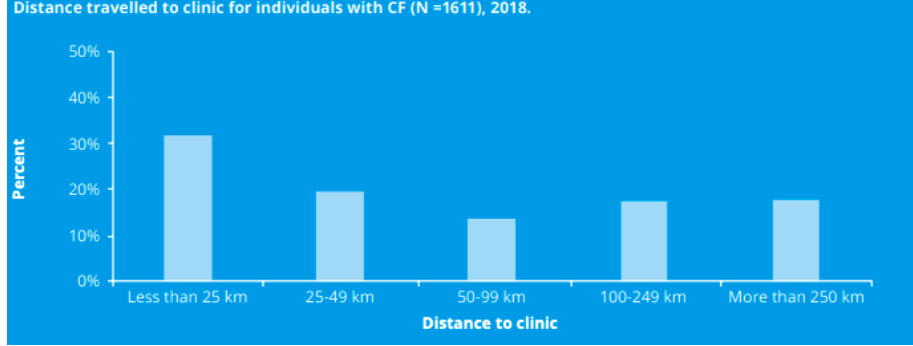
Figure 2. Distance travelled to clinic for individuals with CF, taken from the 2018 Canadian CF Registry Annual Data Report [16]. Registry Annual Data Report